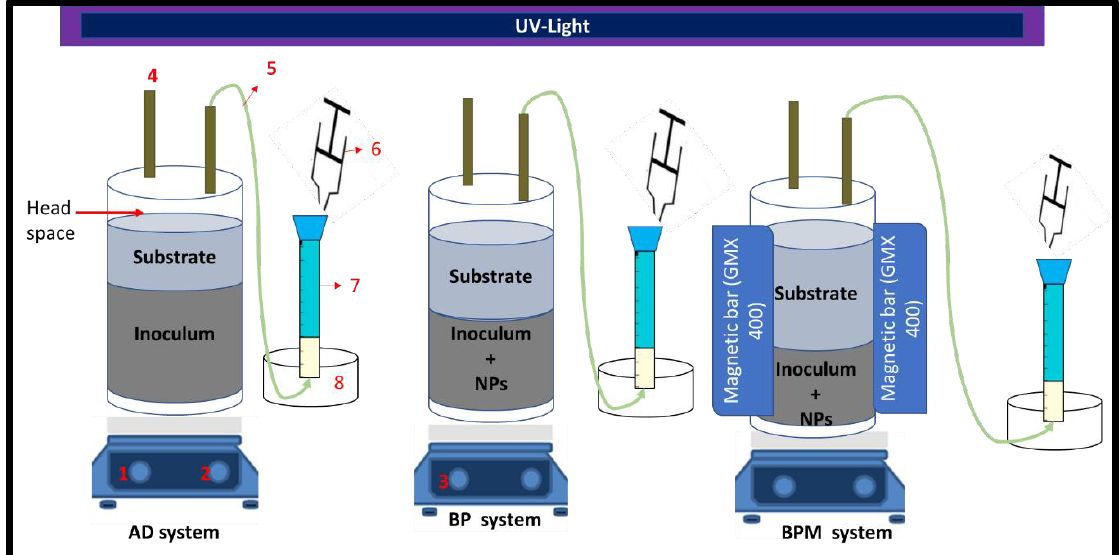
Figure 2. 1: Temperature controller; 2: mixing controller; 3: hotplate magnetic stirrer; 4: purging port; 5: silicon tube; 6: gas sampler; 7: water displacement gas collector; 8: water trough.